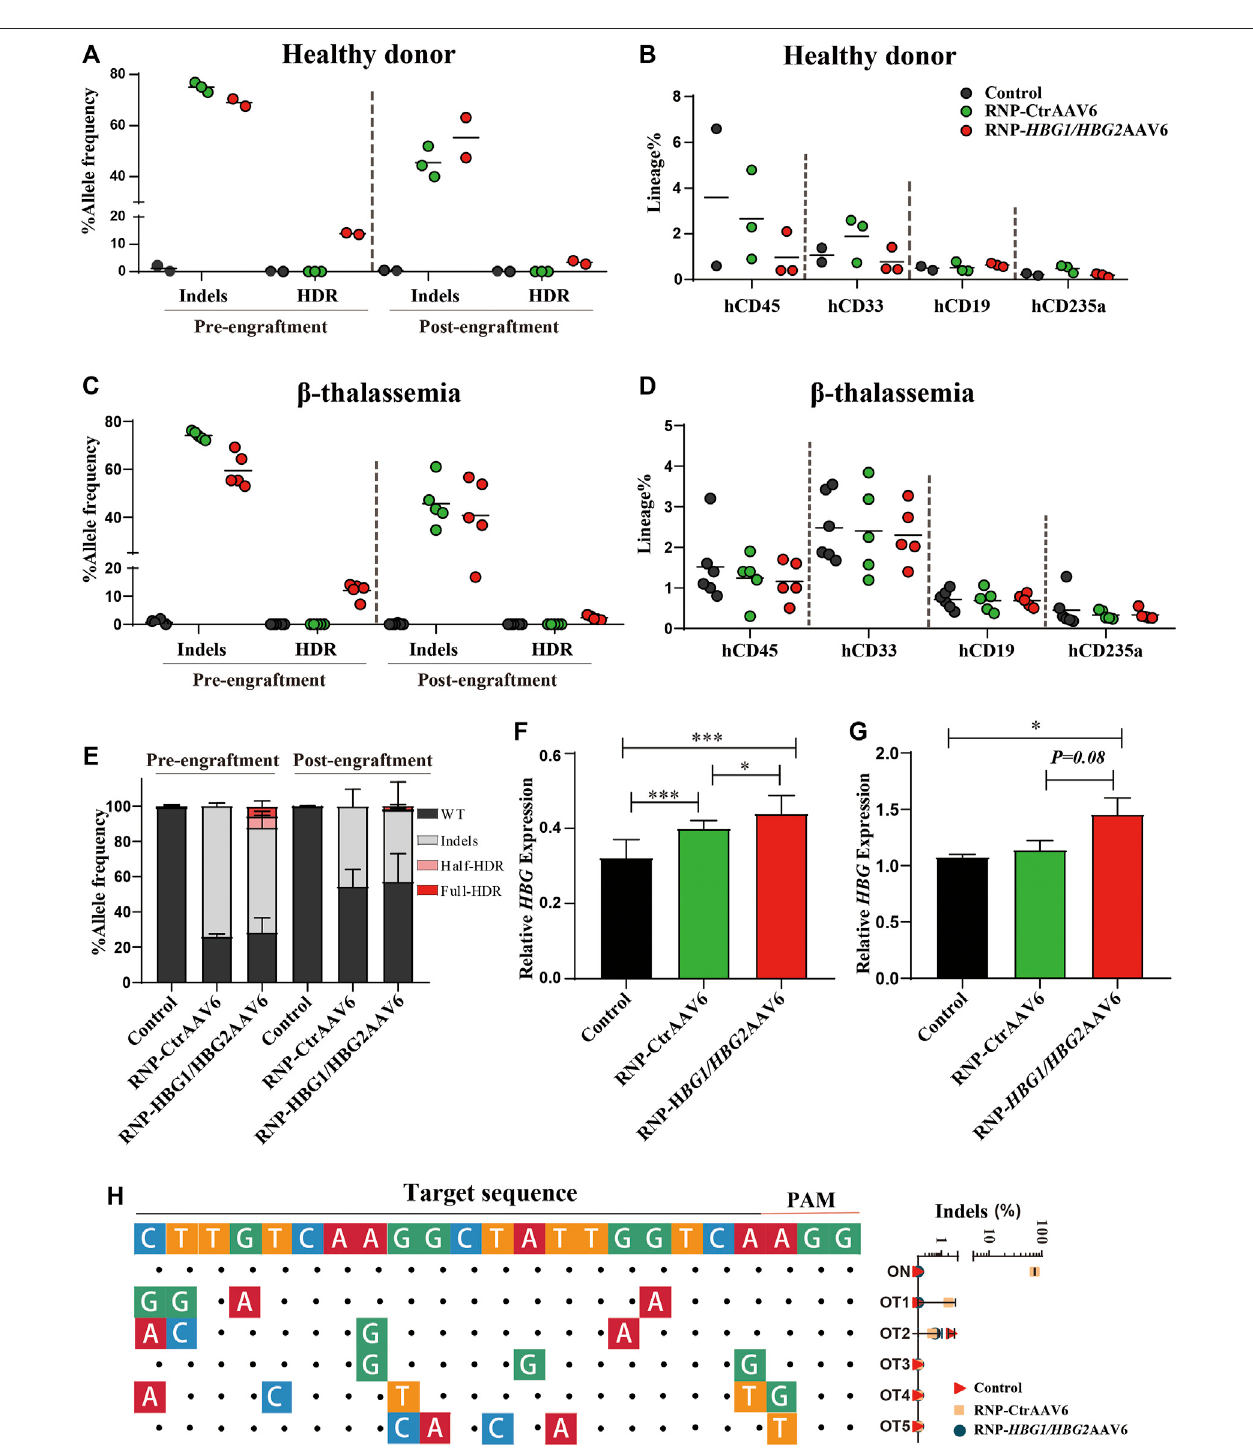
FIGURE 2 | Gene editing of HSPCs induces γ -globin expression and xenotransplantation of gene-edited HSPCs into NBSGW mice. Donor-cell progeny were analyzed in recipient bone marrow (BM) 16 weeks after transplantation. (A,C) Different genotype frequencies in the HSCs of one healthy donor (A) and two thalassemia donors (C) were determined by NGS before or after transplantation. (B,D) Flow cytometry analysis of human CD45 + , CD33 + , CD19 + , and CD235a + cell proportions in mousebonemarrow,whichweregraftedwithHSCsfromonehealthydonor (B) andtwothalassemiadonors (D) at16 weeksaftertransplantation. (E) Percentage of different genotypes frequencies in HSPCs of two thalassemia donors measured by NGS before or after transplantation. (F) Following differentiation of HSPCs into erythrocytes at day 14 in vitro , γ -globin mRNA expression determined by RT-qPCR in edited or non-edited cells of thalassemia donor. (G) γ -globin mRNA expression